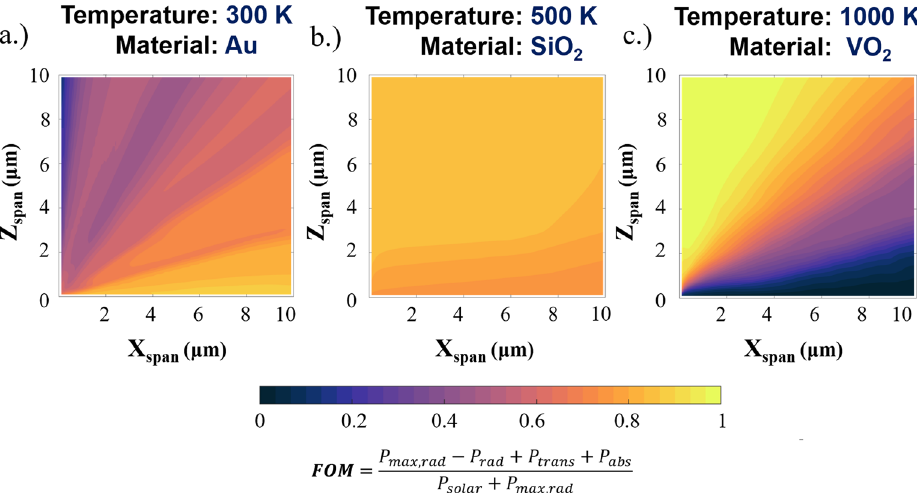
Figure 5. Material search algorithm identifying the most optimal microstructures for cooling at surface temperatures of 300, 500, and 1000 K based on the figure of merit defined by Eqs. (5–6). Due to the role of transmission in Eq. (5), the most optimum microstructure for cooling at room temperature is Au (FOM = 0.772) as typical cooling materials such as PDMS and SiO 2 transmit thermal radiation in the visible wavelengths, negating cooling for a surface below. At 500 K, we identify SiO2 micropyramids as being most optimal (FOM = 0.852). At 1000 K, the algorithm identifies VO 2 as best performing micropyramid structure (FOM = 0.982) among all 41 materials that were predicted by the network. All materials are predicted assuming a minimum wavelength of 0.3 and maximum wavelength of 16 um to capture both thermal emission and solar absorption optical properties.